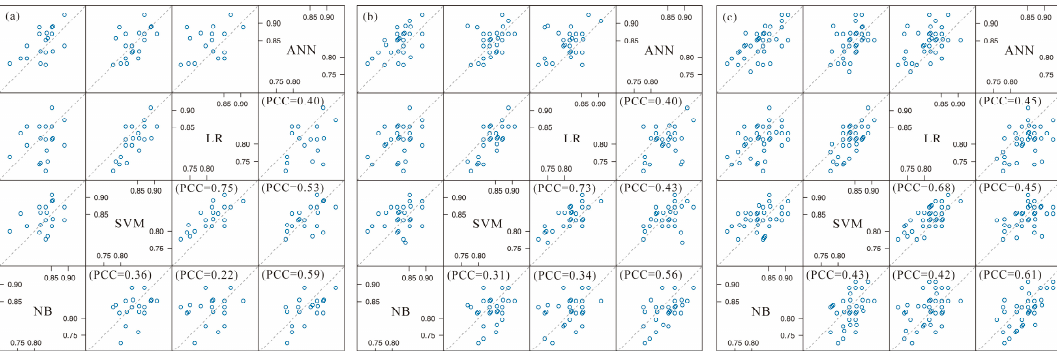
Figure 8. Scatter-plot matrixes of base learners ( a ) on 20 resamples, ( b ) on 30 resamples, ( c ) on 40 resamples. PCC: Pearson’s correlation